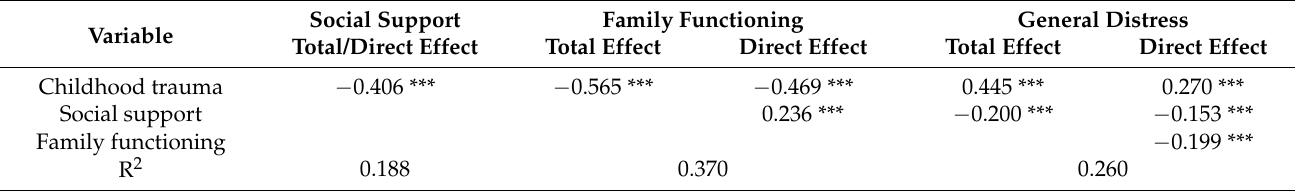
Table 3. Standardized coefficients for total and direct effects on social support, family functioning, and general distress in the serial mediation